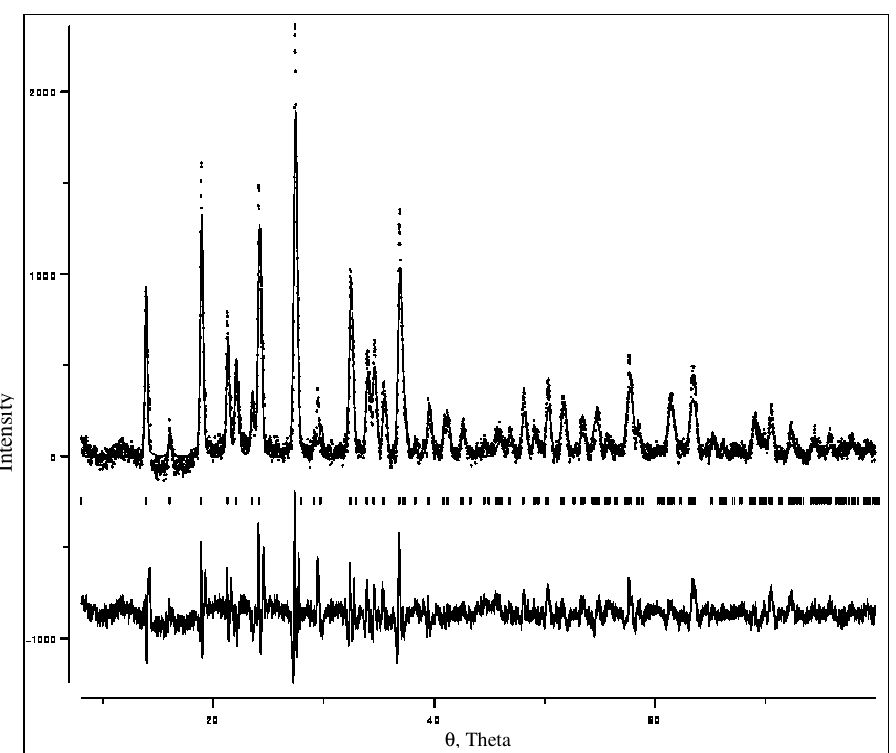
Figure 3. X-ray powder pattern of the nitrate cancrinite. The observed powder pattern together with the difference between observed and calculated intensities (lower part) are